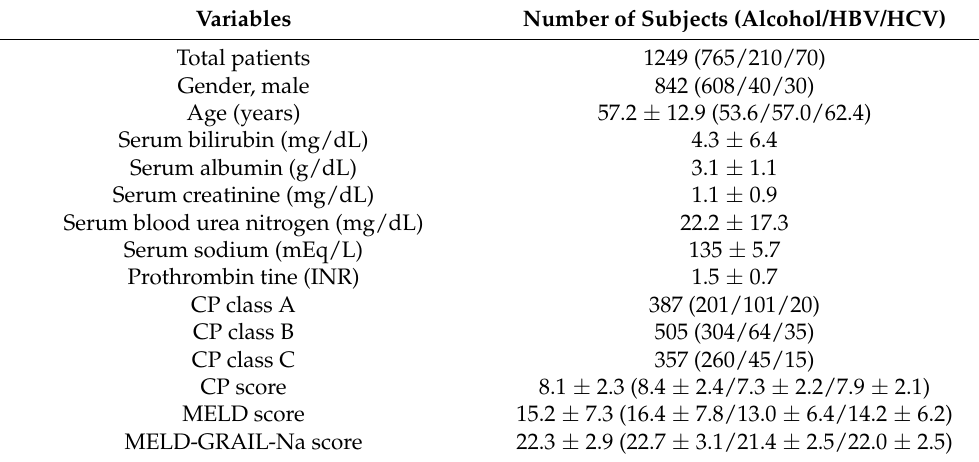
Table 1. Baseline characteristics of the enrolled patients. Variables Number of Subjects (Alcohol/HBV/HCV) Total